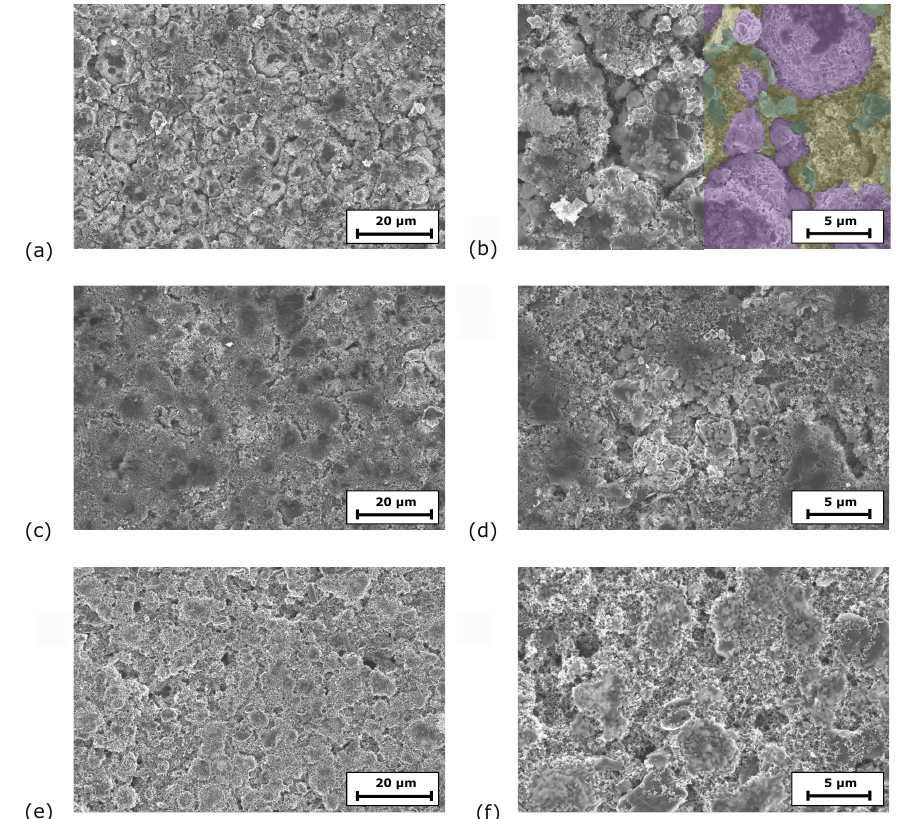
Figure 1. SEM images of ( a , b ) 0PMA (NMC811 particles in purple, KS6L graphite in green and CB in yellow; larger image shown in Figure A2), ( c , d ) 25PMA and ( e , f ) 50PMA at two different magnifications